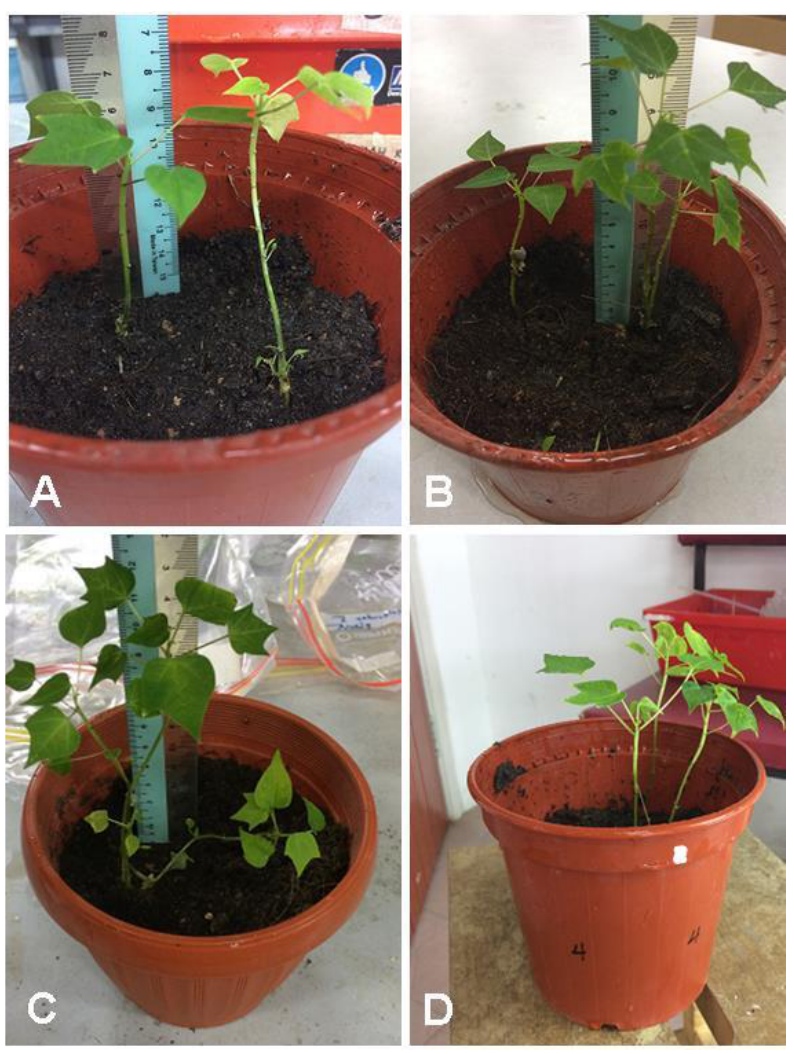
Figure 11. C. papaya “Eksotika” after one month: ( A ) explants regenerated from R1 medium, ( B ) explants regenerated from R2 medium, ( C ) explants regenerated from R3 medium, ( D ) explants regenerated from R4 medium.